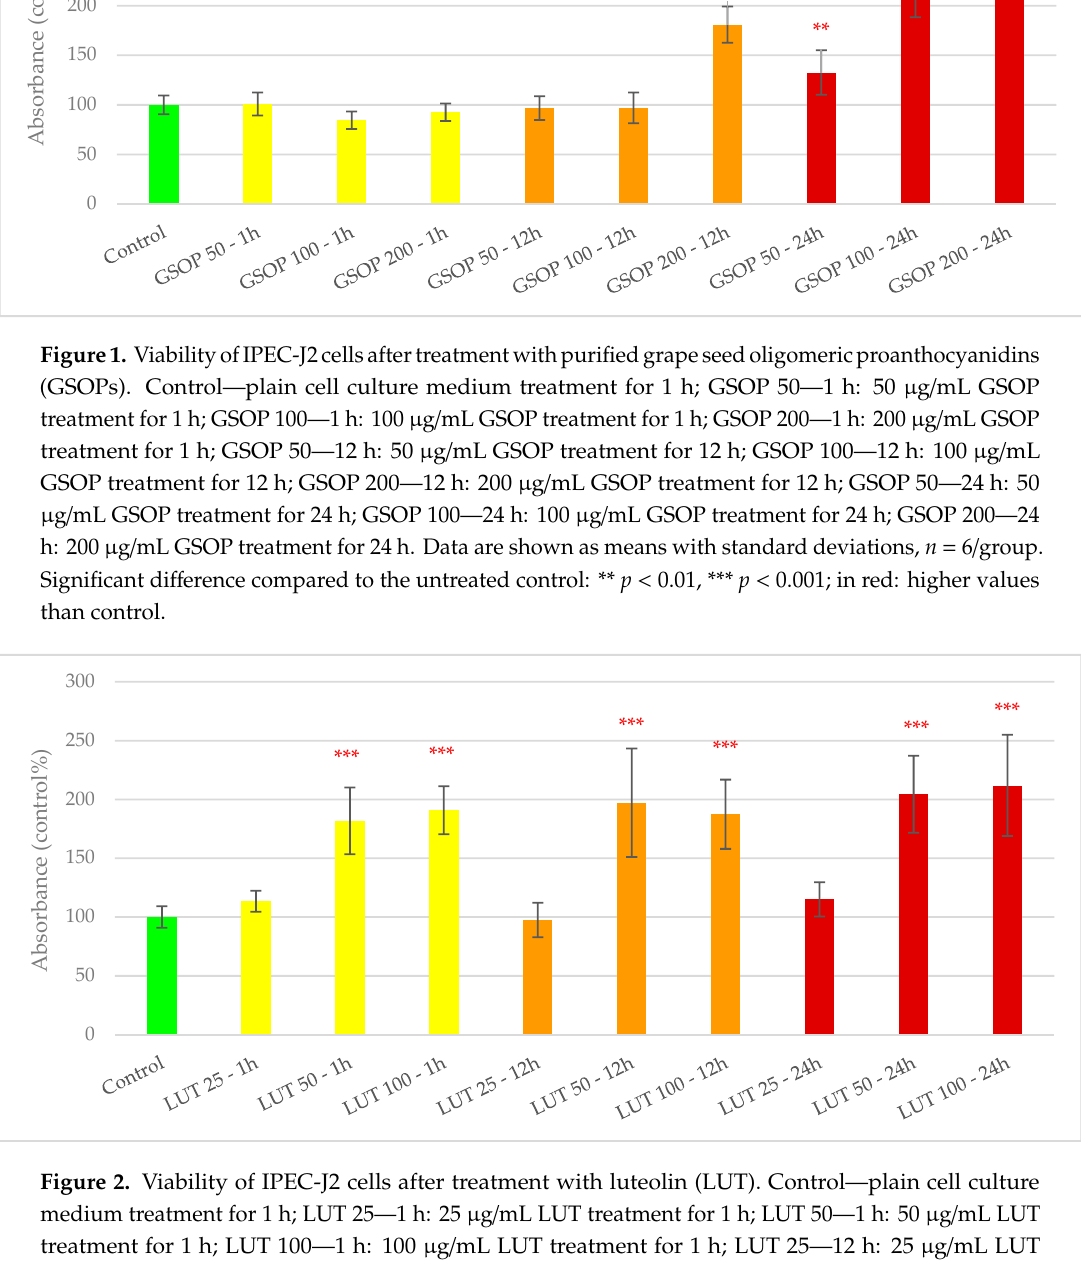
Figure 2. Viability of IPEC-J2 cells after treatment with luteolin (LUT). Control—plain cell culture medium treatment for 1 h; LUT 25—1 h: 25 μ g/mL LUT treatment for 1 h; LUT 50—1 h: 50 μ g/mL LUT treatment for 1 h; LUT 100—1 h: 100 μ g/mL LUT treatment for 1 h; LUT 25—12 h: 25 μ g/mL LUT treatment for 12 h; LUT 50—12 h: 50 μ g/mL LUT treatment for 12 h; LUT 100—12 h: 100 μ g/mL LUT treatment for 12 h; LUT 25—24 h: 25 μ g/mL LUT treatment for 24 h; LUT 50—24 h: 50 μ g/mL LUT treatment for 24 h; LUT 100—24 h: 100 μ g/mL LUT treatment for 24 h. Data are shown as means with standard deviations, n = 6 / group. Significant di ff erence compared to the untreated control: *** p < 0.001; in red: higher values than